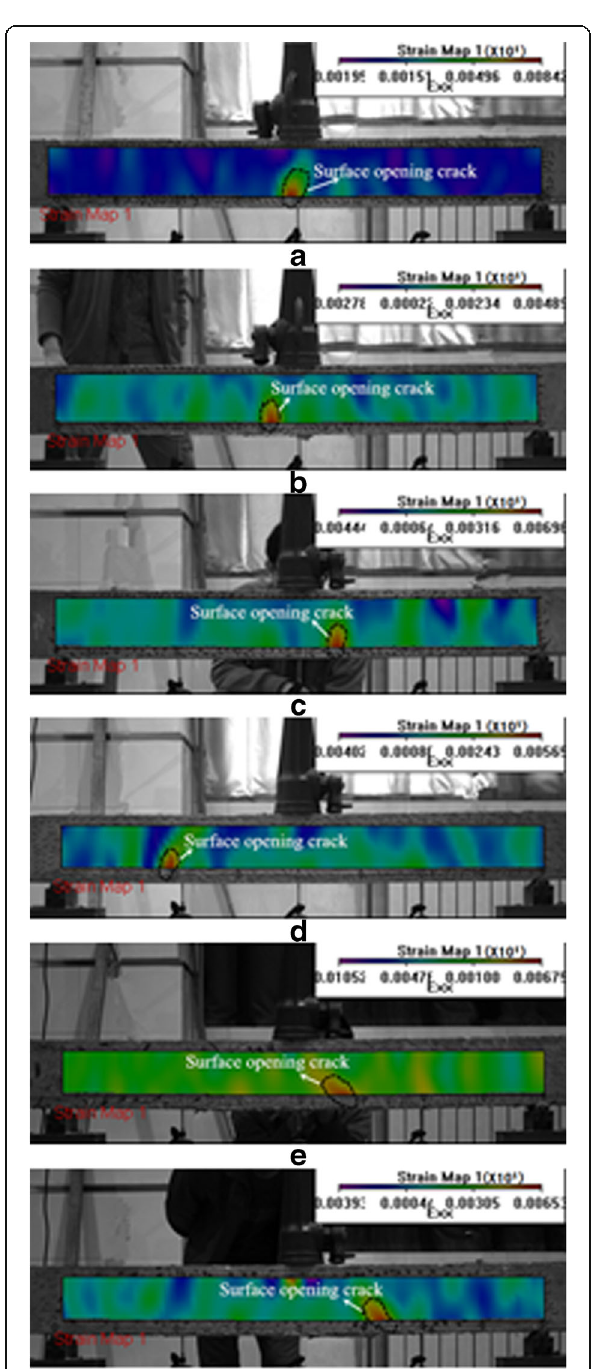
Fig. 9 View of non-contact video-based test result showing strain map of different beams: ( a ) 12-1# beam; ( b ) 12-2# beam; ( c ) 12-3# beam; ( d ) 16-1# beam; ( e ) 16-2# beam; ( f ) 16-3#